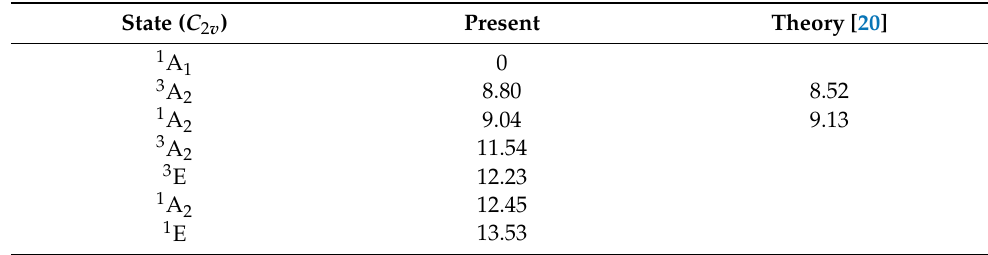
Table 1. Electronic vertical excitation energy at the c -C 4 F 8 ground-state geometry. The results are compared with previous theoretical calculations [20] in eV.